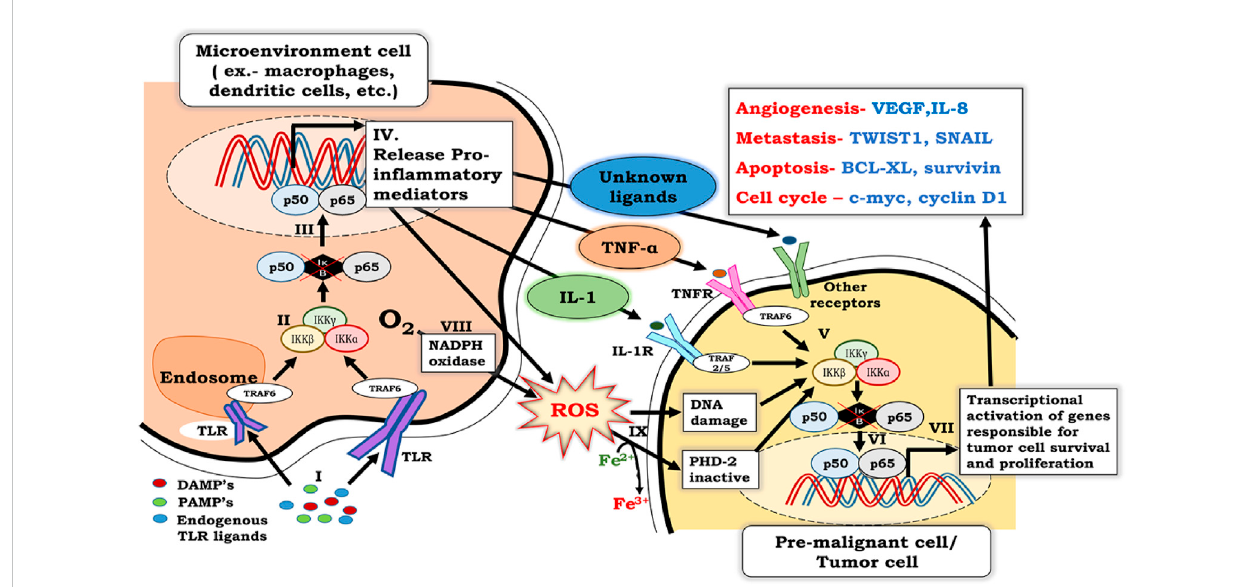
FIGURE 1 Crosstalkbetween NF- κ Bsignaling inin fl ammatorycellsandpremalignantcells.I.NF- κ Bactivation inin fl ammatorycellsinvolvesbindingofPAMPs, DAMPs, and endogenous TLR ligands with TLR receptors, which are associated with TRAF-6. II. Binding of PAMPs, DAMPs, and endogenous TLR ligands with TLR ’ s leads to activation of the IKK αβγ complex, which further results in phosphorylation, ubiquitination, and degradation of I κ B. III. Degradation of I κ B renders p50 and p65 heterodimers free to migrate to the nucleus and activate NF- κ B. IV. Activation of NF- κ B in in fl ammatory cells results in the secretion of pro-in fl ammatory cytokines, including TNF- α and IL- 1. V. Released pro-in fl ammatory cytokines bind to their speci fi c receptors on pre- malignant cells and activate the IKK αβγ complex, which further results in phosphorylation, ubiquitination, and degradation of I κ B. VI. Degradation of I κ B renders p50 and p65 heterodimer free to migrate to the nucleus and activates the transcription of genes responsible for cell survival, proliferation, migration, metastasis, and angiogenesis. VII. ROS generated by phagocytic NADPH to counter infectious pathogens, along with the ROS generated by activationofNF- κ Binin fl ammatorycells,entersthecytosol.VIII.OxidativestresscausedbylargeamountsofROSnotonlydamagesDNA,butalsoionizes Fe 2+ to Fe 3+ .As aresult,PHD-2, which requires Fe 2+ as acofactorfor itsactivity,isinactivated. ROS-induced DNAdamageand PHD-2 inactivation further contribute to NF- κ B activation in pre-malignant